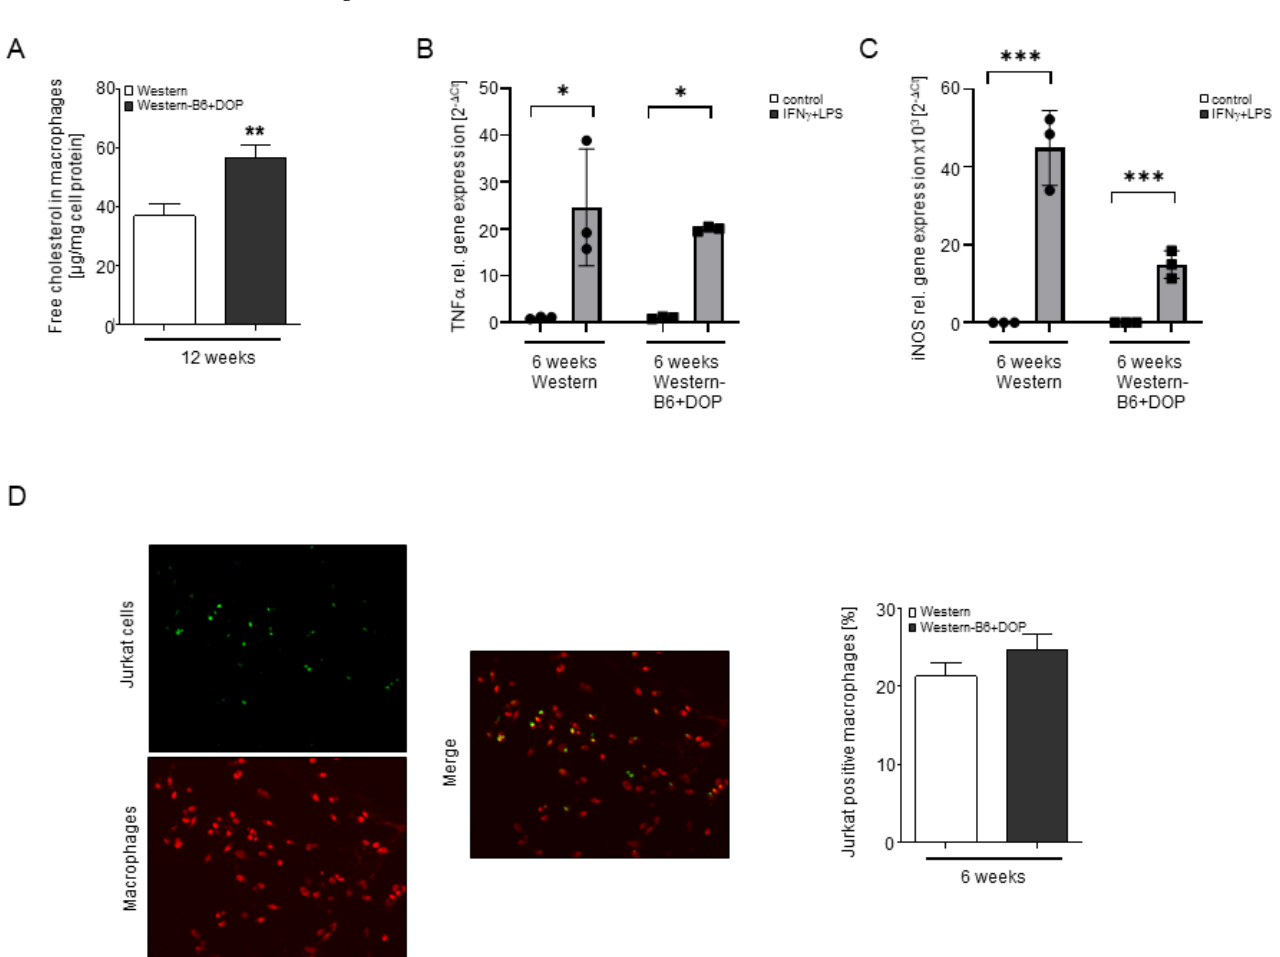
Figure 5. High intracellular cholesterol but unaltered polarization, inflammation and efferocyto- sis after lyase inhibition. ( A ) Free cholesterol content of resident peritoneal macrophages isolated from mice after 12 weeks of DOP treatment and their respective controls. Statistically significant differences from controls are indicated as ** p < 0.01 (Student’s t -test). ( B ) and ( C ) Quantification of TNF ( B ) and iNOS ( C ) gene expression by qRT-PCR analysis in thioglycollate-elicited peritoneal macrophages isolated from ApoE − / − mice on Western versus Western-B6+DOP diet for 6 weeks and stimulated or not in vitro with 1 µM LPS and 250 U IFN for 6 h. Data are presented as mean ± SEM. Statistical analysis was performed using a one-way ANOVA followed by a Tukey’s post hoc test. Statistically significant differences from controls are indicated as * p < 0.05, and *** p < 0.001. ( D ) Comparison of macrophage phagocytosis of apoptotic Jurkat cells between thioglycollate-elicited peritoneal macrophages from ApoE − / − mice fed a Western or Western-type-B6+DOP diet for 6 weeks. Representative images of macrophages, apoptotic Jurkat cells, overlay of both (left) and quantifica- tion (right). Results are shown as mean ± SEM. There were no statistically significant differences (Student’s t -test).